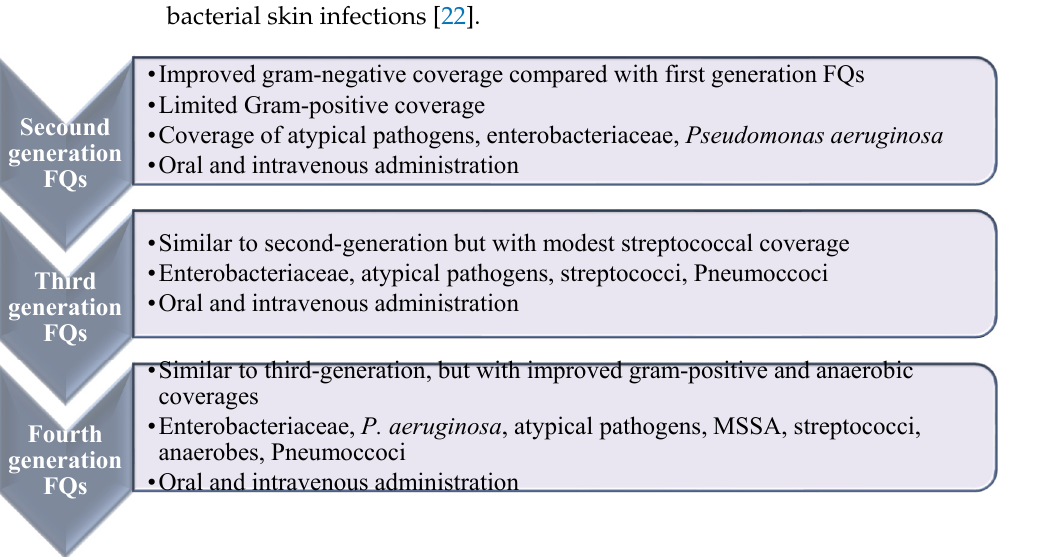
Figure 2. Spectrum and antimicrobial activities of fluoroquinolone based on their generations. Widening of the antibacterial activity of fluoroquinolones in relation to their generation. Repro- duced/adapted from ref. [13] .